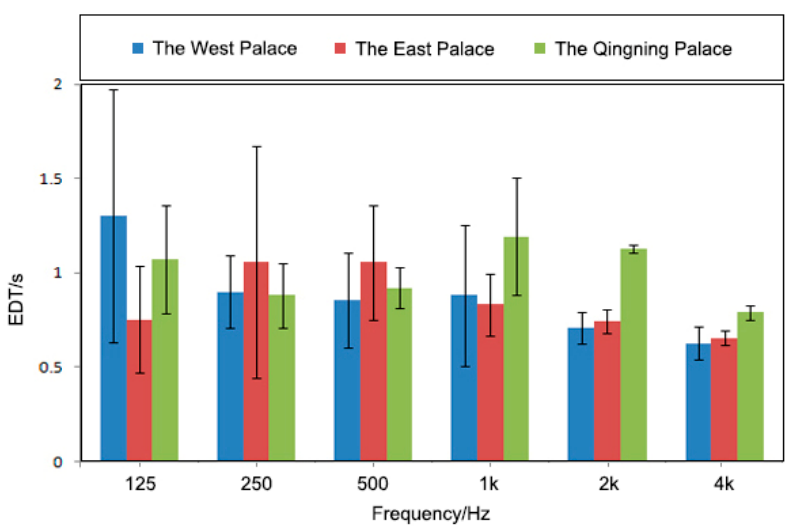
Figure 4. Average values of measured EDT in three traditional courtyards.